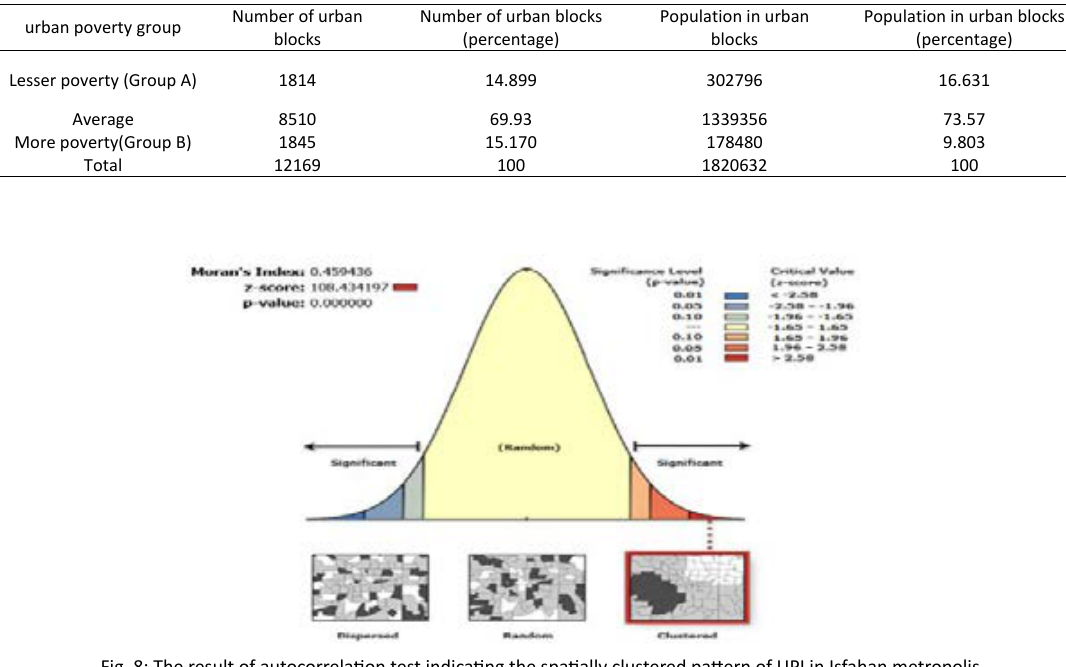
Fig. 8: The result of autocorrelation test indicating the spatially clustered pattern of UPI in Isfahan metropolis